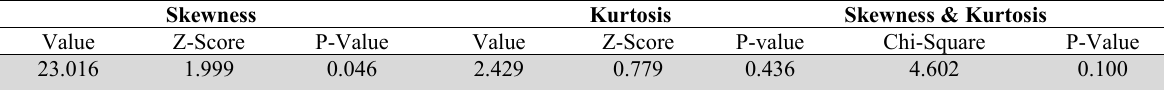
Multivariate Testing Results